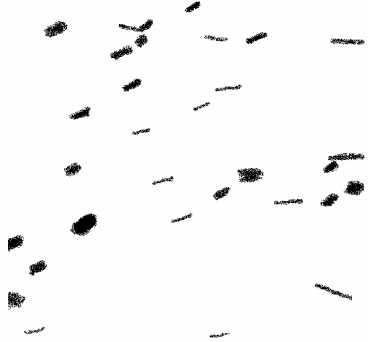
Figure 8. Background noise removal and pixel enhancement of Figure